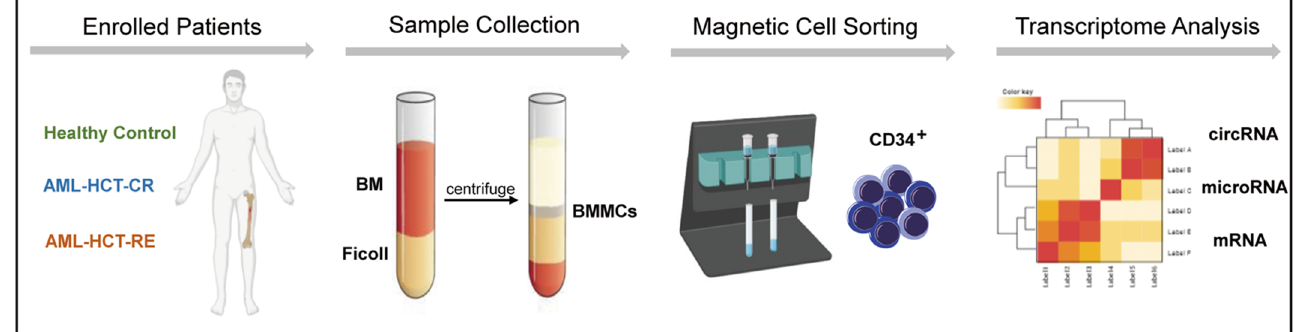
Figure 1. Schematic of RNA-seq analysis of BM-purified CD34 + cells from AML patients with relapse (RE), remission (CR) and healthy controls (HC).